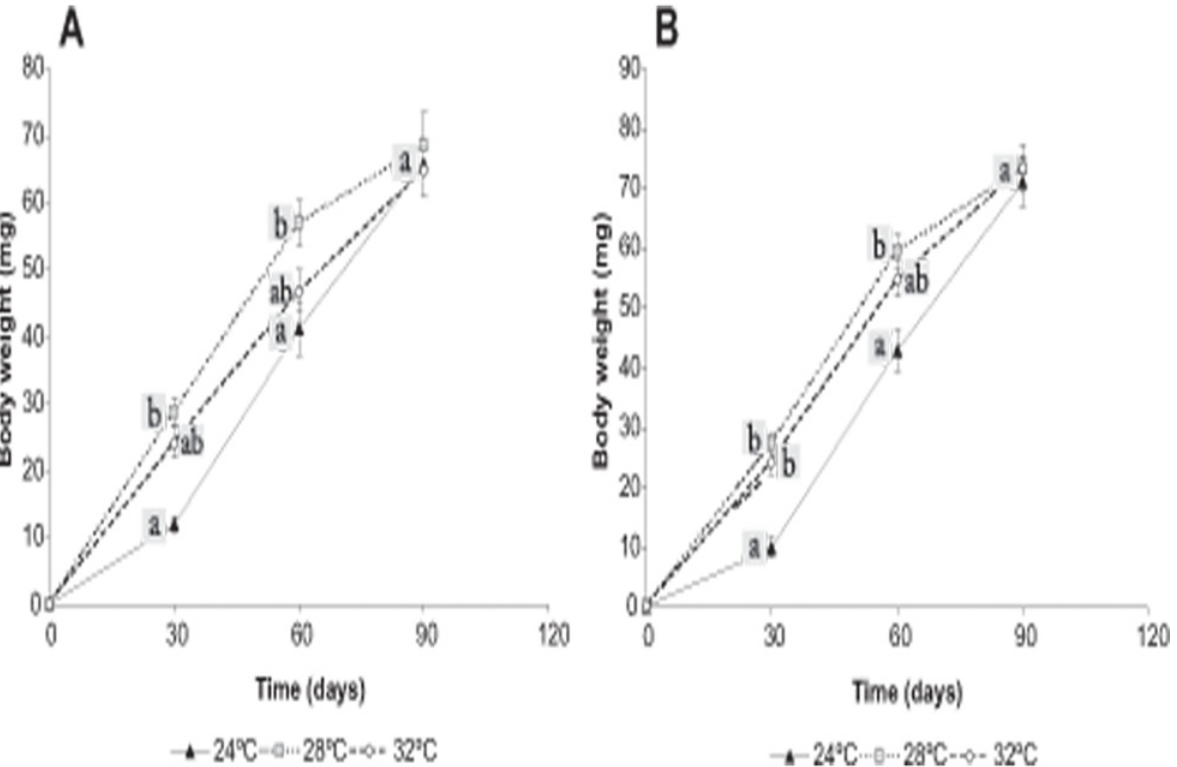
Fig 3. Body weight (mean ± SE) of shrimps during the Growth period of Experiment 1 (A) and Experiment 2 (B). Neocaridina heteropoda heteropoda juveniles were reared at three different water temperatures (24, 28 or 32°C) over a 90-day period, and the body weight was recorded every 30 days. Different letters at days 30 and 60 indicate statistically significant differences among treatments ( P < 0.05); the letter “ a ” at day 90 indicates the absence of statistically significant differences among treatments ( P > 0.05). In both experiments, body weight of shrimps maintained at 24°C was lower than that of shrimps maintained at 28°C at days 30 and 60, but this difference was no longer significant at day